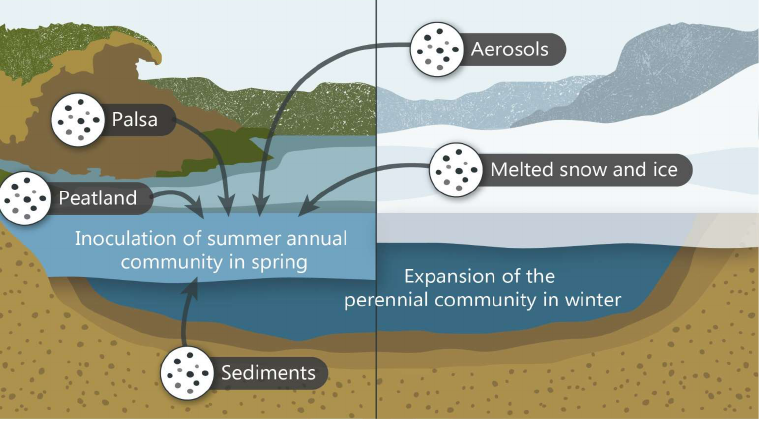
Figure 5. Visual representation of the proposed model of viral community transition in thermokarst lakes between summer and winter.